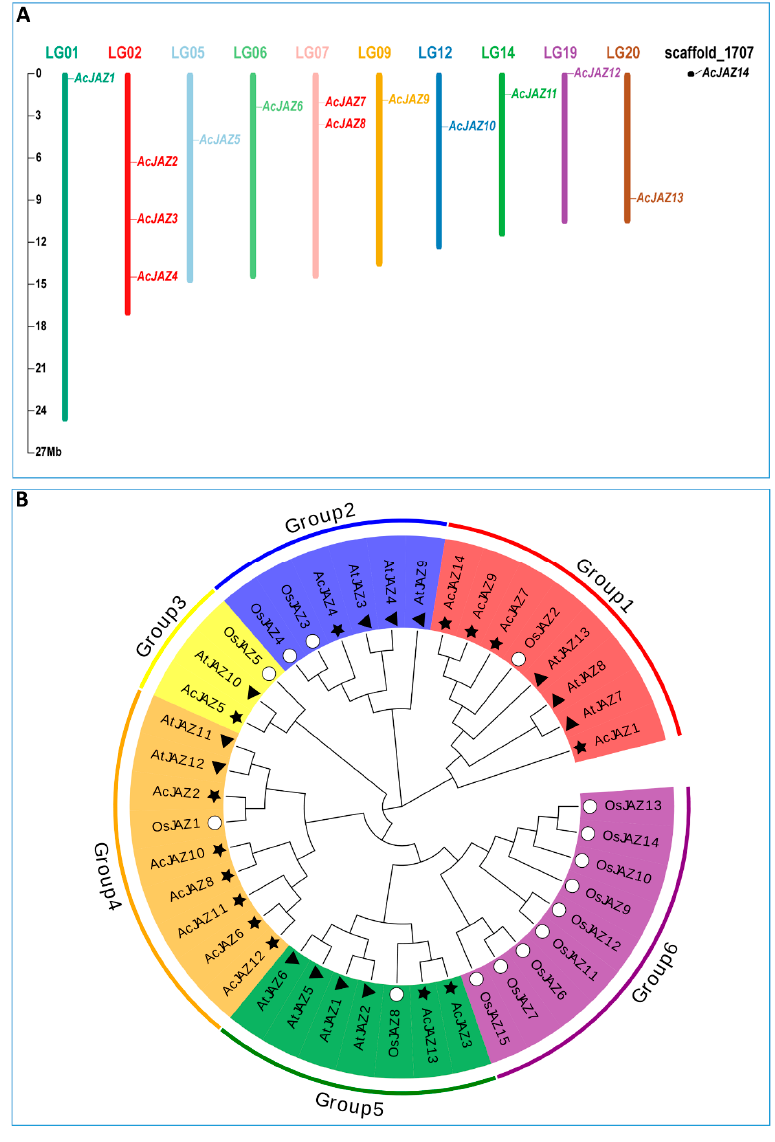
Figure 1. The JAZ gene family in pineapple. ( A ) Chromosomal locations of JAZ genes in pineapple. The respective chromosome number is indicated by different colors at the top of each chromosome. The scale on the left is for chromosomes in megabases ( B ) Phylogenetic relationship of JAZ proteins from Arabidopsis thaliana , Oryza sativa , and pineapple. The phylogenetic tree was created using the neighbor-joining method with 1000 bootstrap replicates by MEGA 7. The diverse groups of JAZ proteins are marked with different colors. The JAZ proteins of A. thaliana , O. sativa , and pineapple are represented by black triangles, white circles, and black stars, respectively.